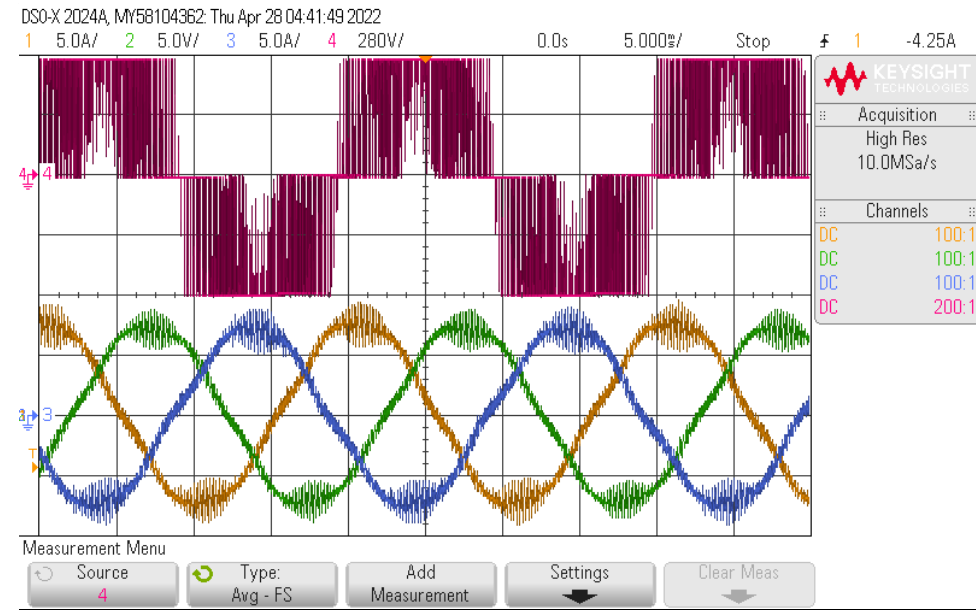
Figure 6. Oscilloscope voltage and current waveforms for the CL